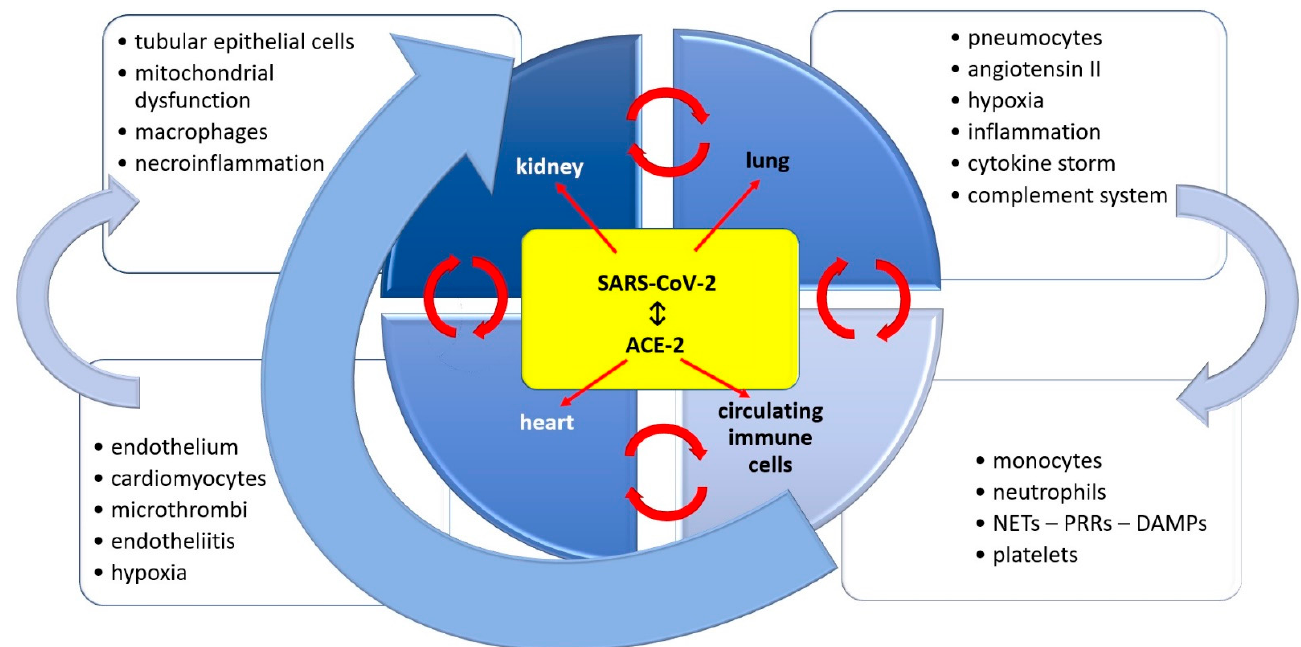
Figure 1. Interorgan and innate immunity cell crosstalk in COVID-19 infection. NETs—neutrophil extracellular traps; PRRs—pattern recognition receptors; DAMPs—damage-associated molecular patterns.